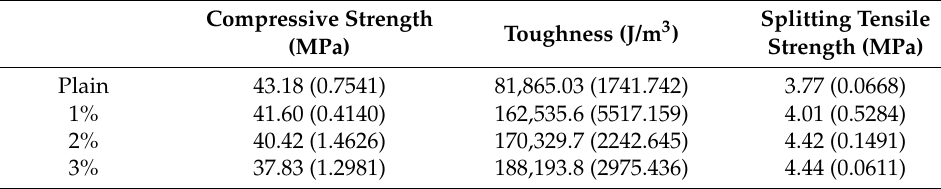
Table 7. Compressive behavior comparison of 1% (by volume) polymeric and recycled polymeric reinforced concrete.